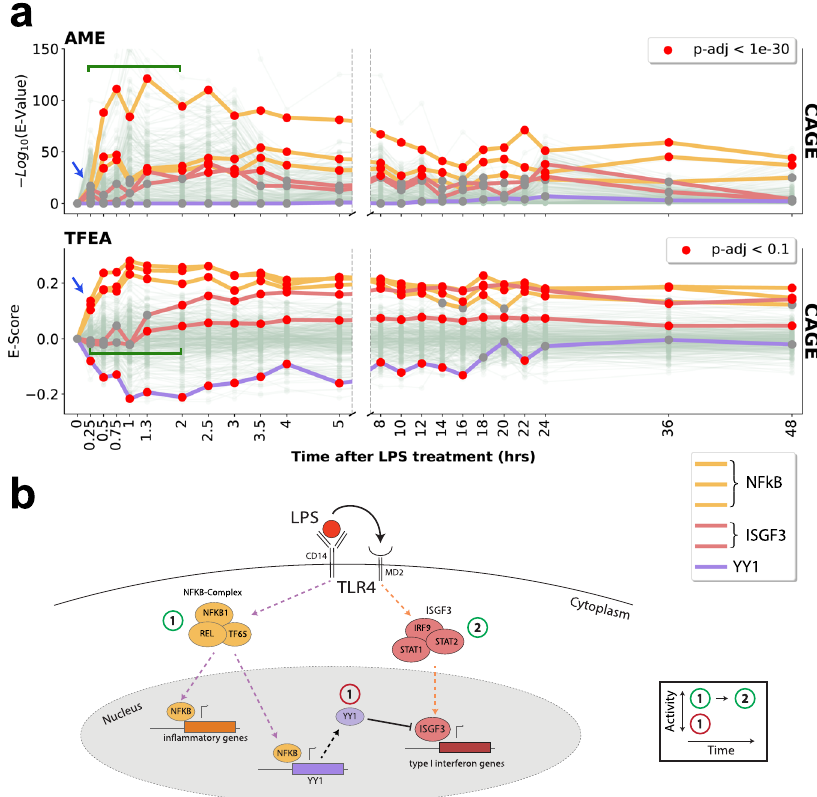
Fig. 5 TFEA dissects the temporal dynamics of infection. a Analysis of lipopolysaccharide (LPS) time-series cap analysis gene expression (CAGE) data 10, 25 using AME and TFEA. Trajectories of activity pro fi les show LPS triggers immediate activation of the NF- κβ complex (TF65/RelB/NFKB1; yellow), observable at 15 min (blue arrow). TFEA detects a concomitant downregulation of a set of transcription factors, exempli fi ed here by TYY1 (purple). TFEA also resolves subsequent dynamics (green bracket) of ISGF3 activation (containing IRF9/STAT1/STAT2; red lines). b Schematic depicting the molecular insights gained from TFEA analysis. See Supplementary Fig. 19 for more analysis. See Supplementary Data 1 for a complete list of accession numbers for data